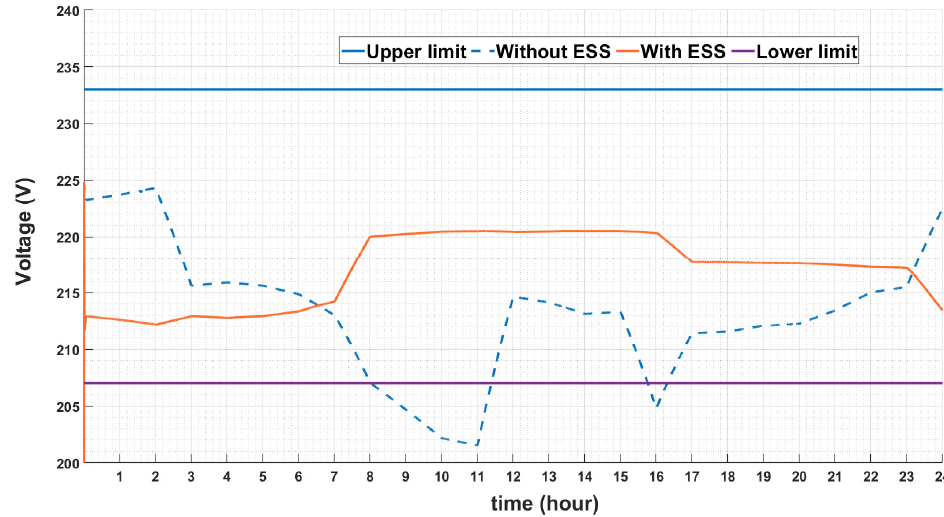
Figure 19. Minimum BUS voltage with/without ESS.